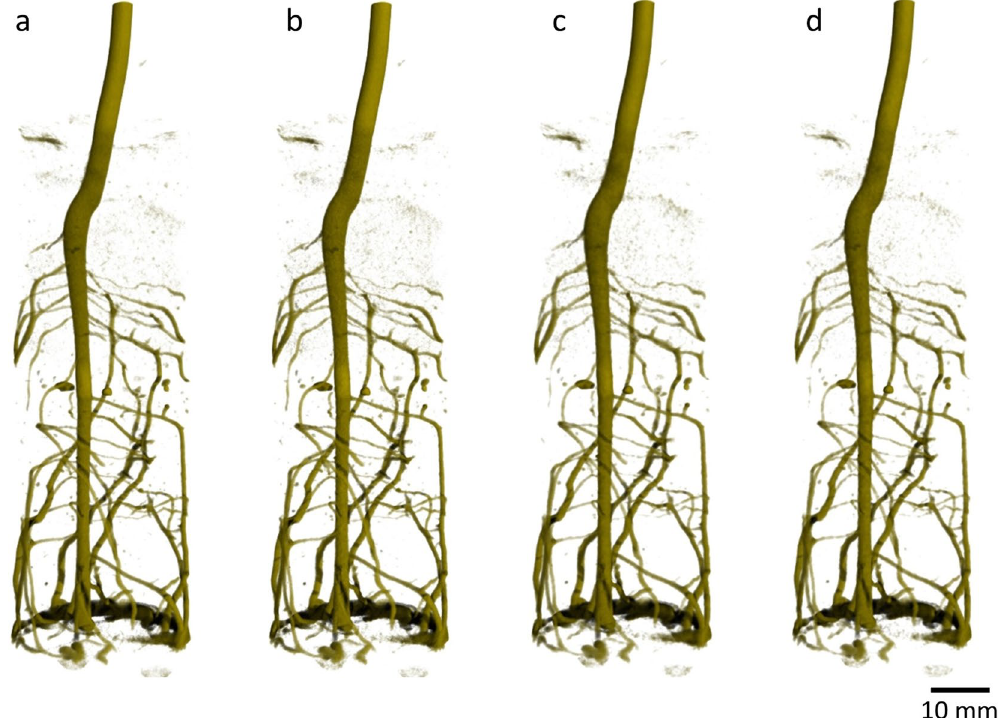
Figure 1. Lupine root system grown in sandy soil (total soil water content was 0.10 cm 3 /cm 3 ) captured by ultra- fast neutron tomography at increasing speed of measurement. Total acquisition times were ( a ) 60 s, ( b ) 30 s, ( c ) 15 s ( d ) 10 s, and all 3D views are shown from the same perspective. Even at highest speed the major features of the root system are